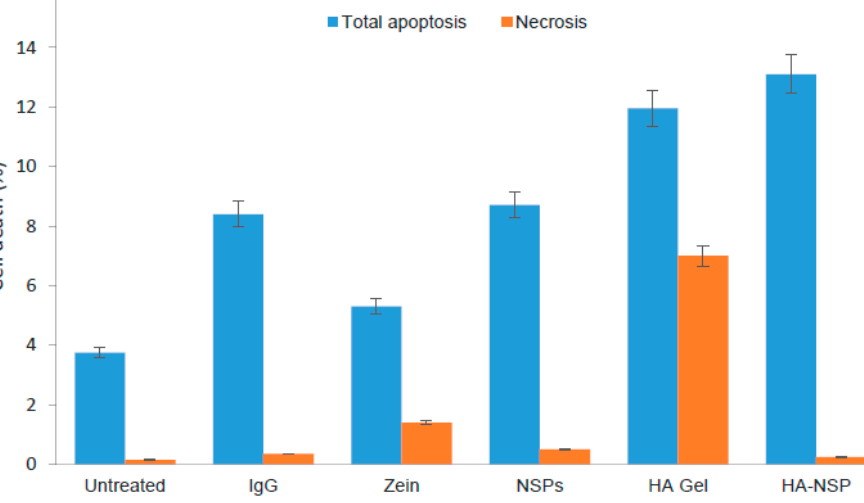
Figure 17. HRPE cell death presented as percentage apoptosis and necrosis ( p = 0.004).